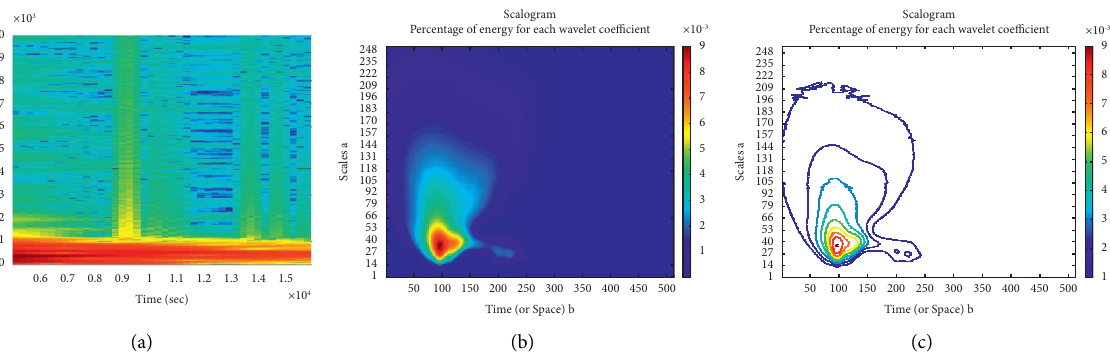
Figure 3: (a) Spectrogram of GPR signal of dry ballast. (b), (c) Wavelet spectrum of GPR signal of dry ballast.